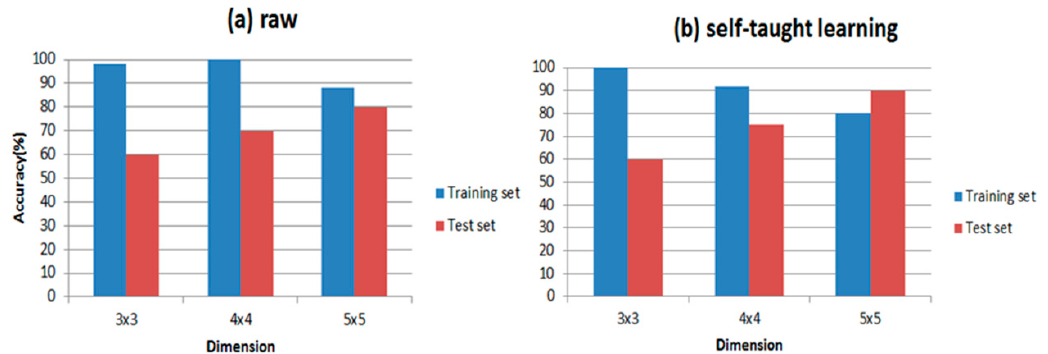
Figure 9. Accuracy with RBF. When dimension changes from 3 × 3 to 5 × 5, ( a ) shows the accuracy of unprocessed data set (training set and test set); ( b ) shows the accuracy of data set processed by self taught learning.